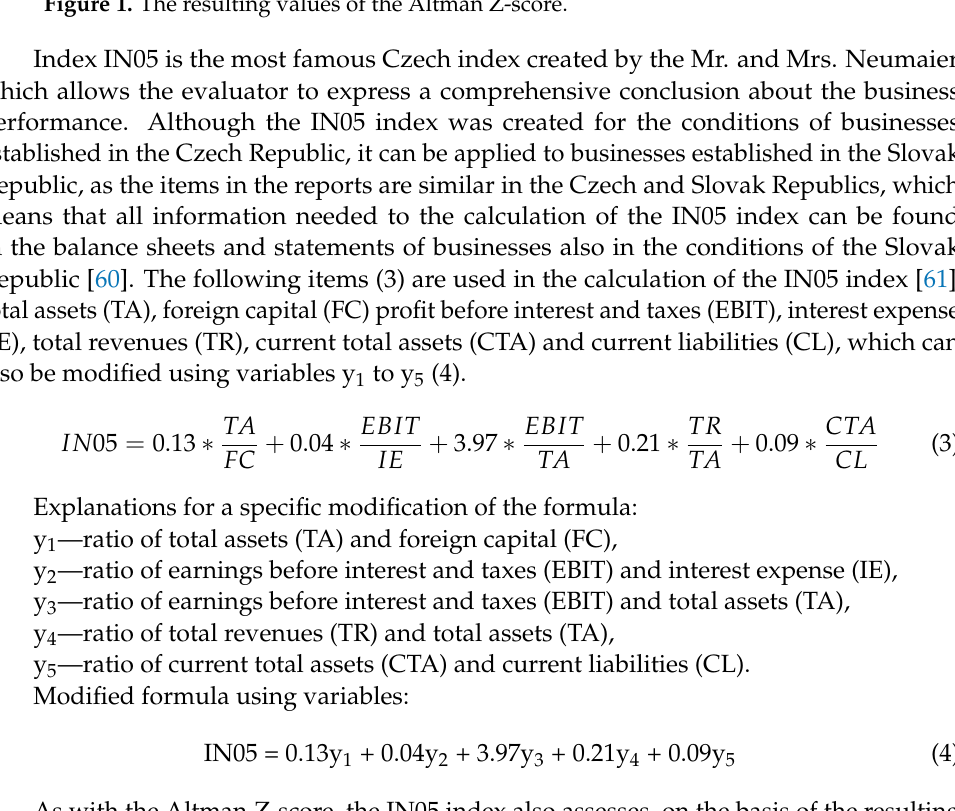
Figure 1. The resulting values of the Altman Z-score.